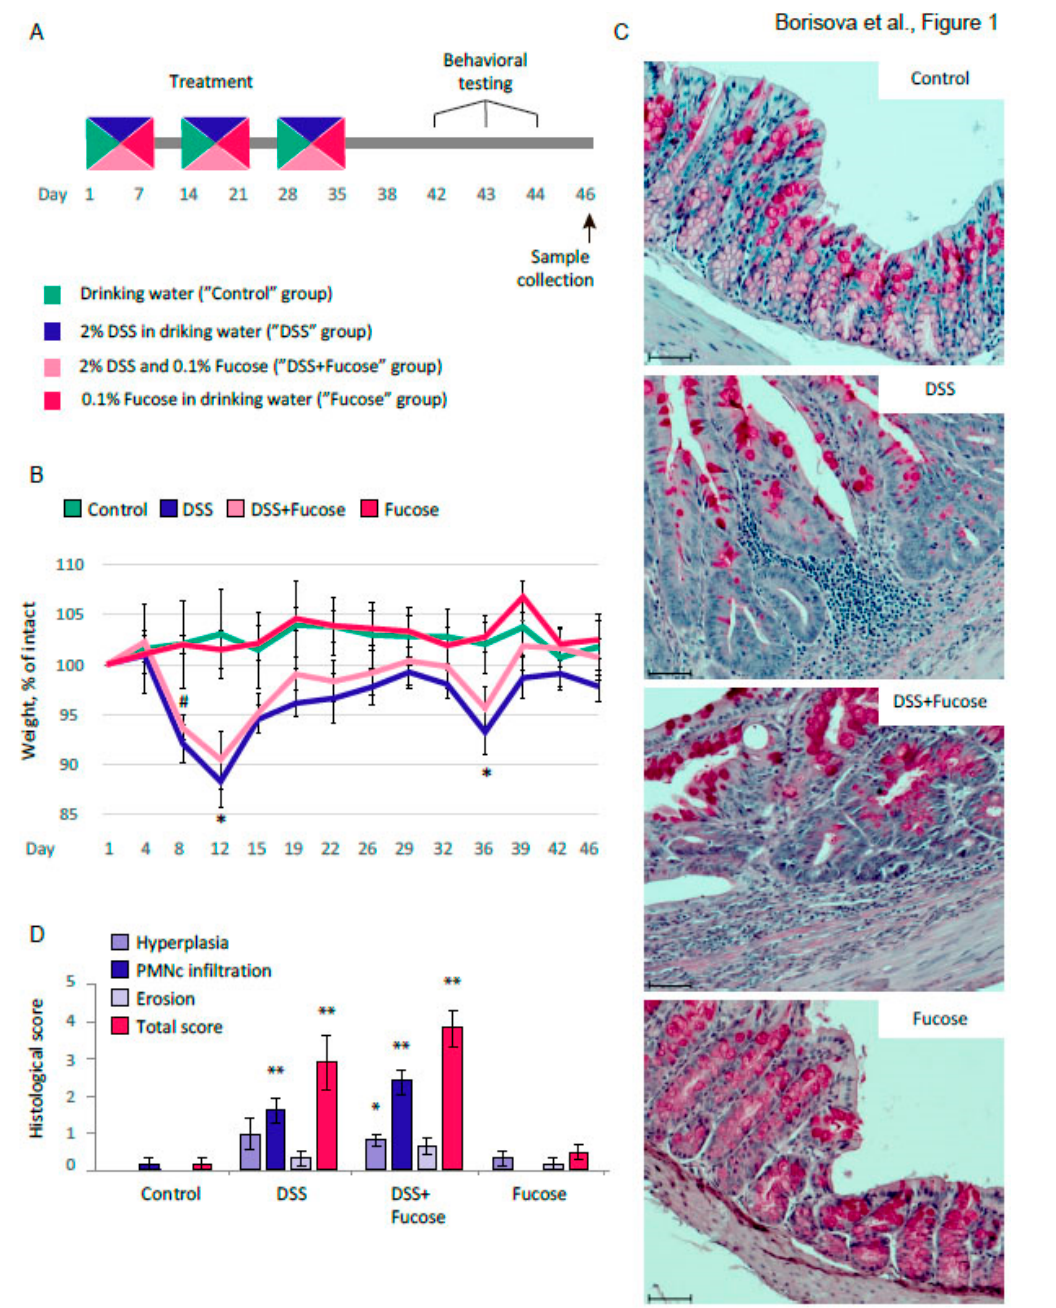
Figure 1. Fucose does not improve inflammatory response to chronic DSS treatment. ( A ) Chronic DSS treatment experimental design; ( B ) Body weight dynamics during chronic DSS-induced colitis. * = p < 0.05, “DSS” vs. “Control”, # = p < 0.05, “DSS + Fucose” vs. “Control”, Student’s t -test for independent samples. ( C ) PAS-stained histological sections of descending colon (scale bar 50 µm). ( D ) Histological scoring of the inflammatory response. * = p < 0.05, ** = p < 0.01, vs. “Control”, Mann-Whitney u -test).